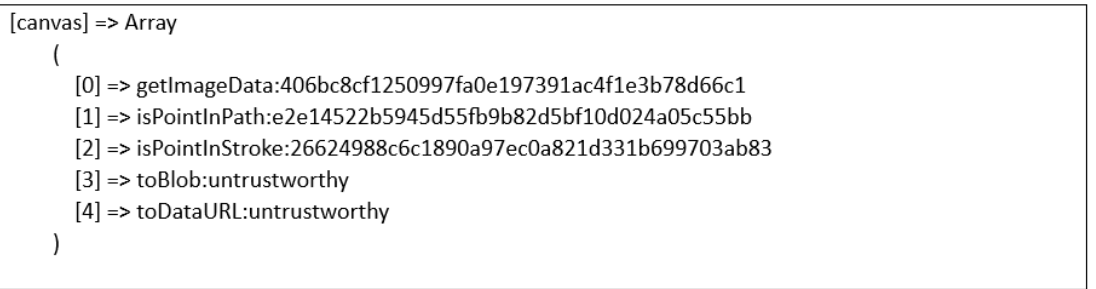
Figure 8. Example of canvas fingerprint attribute data collected in a text file.